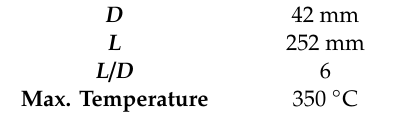
Table 1. The main technical features of the twin screw counter-rotating Brabender extruder.